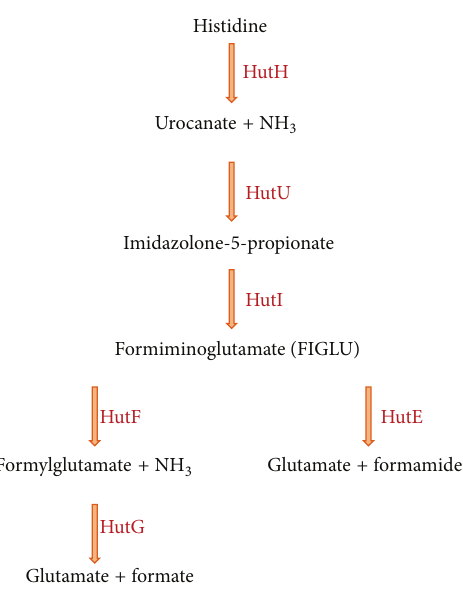
Figure 6: Histidine utilization pathway in P. aeruginosa. This strain can metabolize histidine either through a four-step or a five-step pathway. P. fluorescens is only capable of utilizing histidine through the five-step